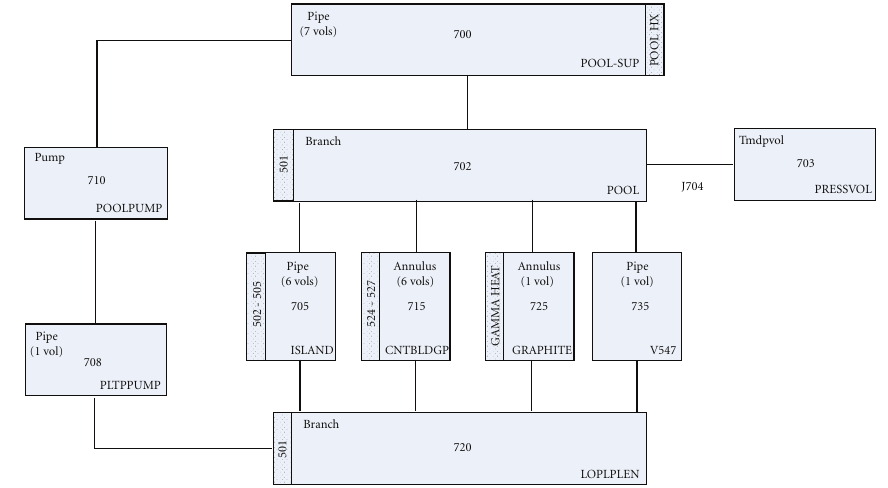
Figure 3: RELAP/SCDAPSIM nodalization of the MURR bulk reactor pool and pool coolant loop.